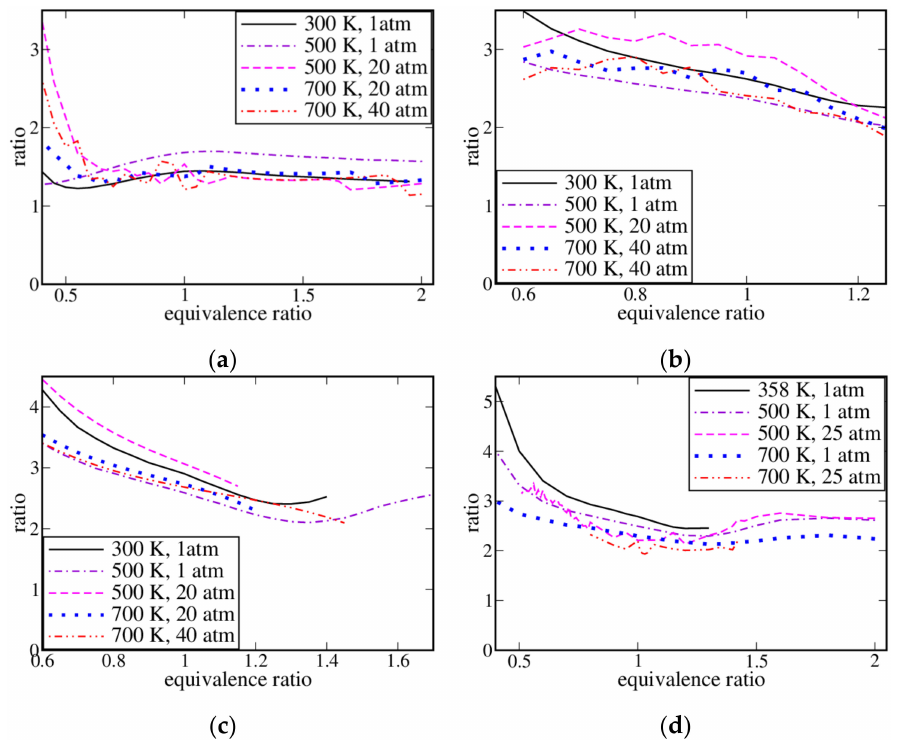
Figure 7. Dependencies of the ratio δ L / δ T r on the equivalence ratio, calculated for ( a ) H 2 , ( b ) CH 4 , ( c ) C 3 H 8 , and ( d ) n -C7H16, calculated for various pressures P and unburned gas temperatures T u , specified in